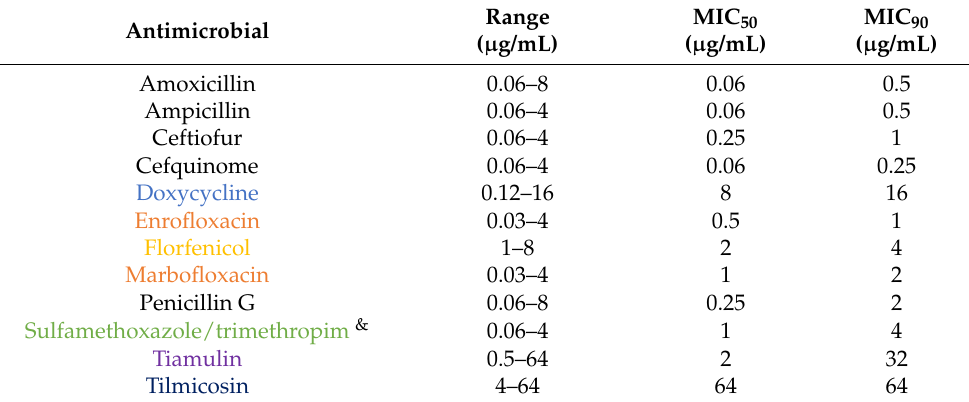
Table 2. Streptococcus suis MIC range, MIC 50 and MIC 90 for 398 strains isolated from systemic clinical cases. The same color in the antimicrobial column represents member of the same antimicrobial family. Antimicrobial